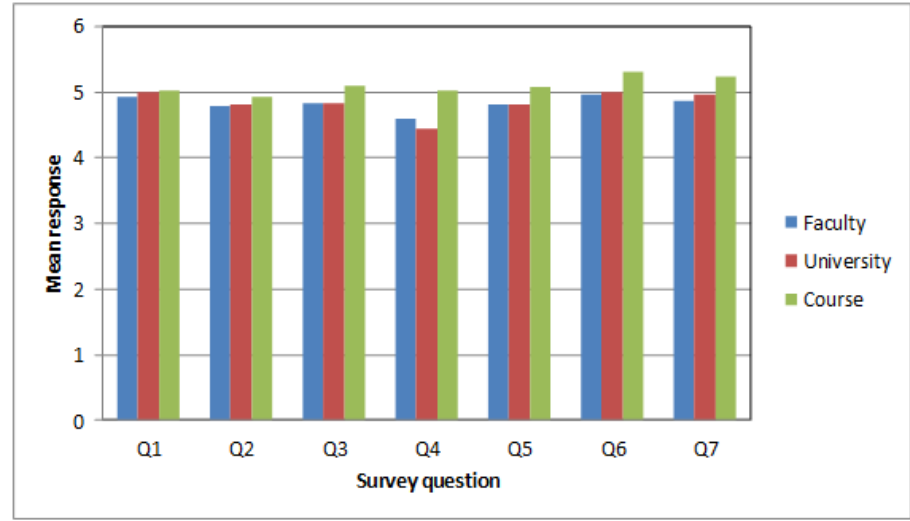
Figure 4: Overall